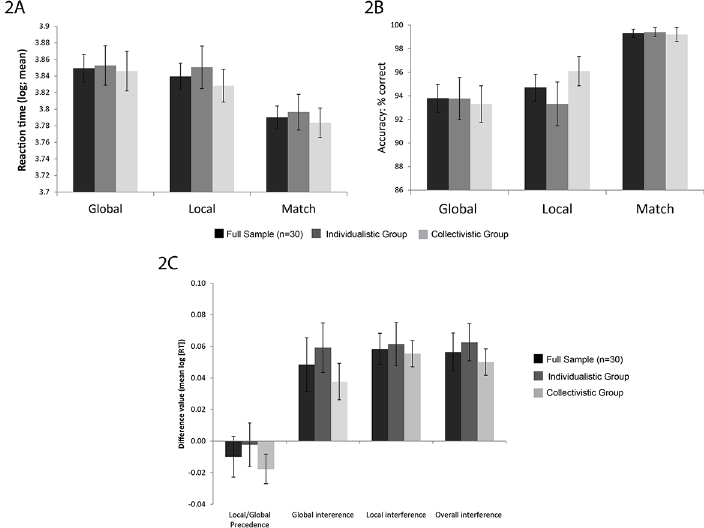
Fig 2. Behavioural data for individualistic and collectivistic groups. 2A: Mean reaction time (log) for global, local, match trials; 2B: Accuracy (% correct) for global, local and match trials. 2C: Precedence and interference indices based on reaction time. Also included is data for the whole sample. Error bars are standard